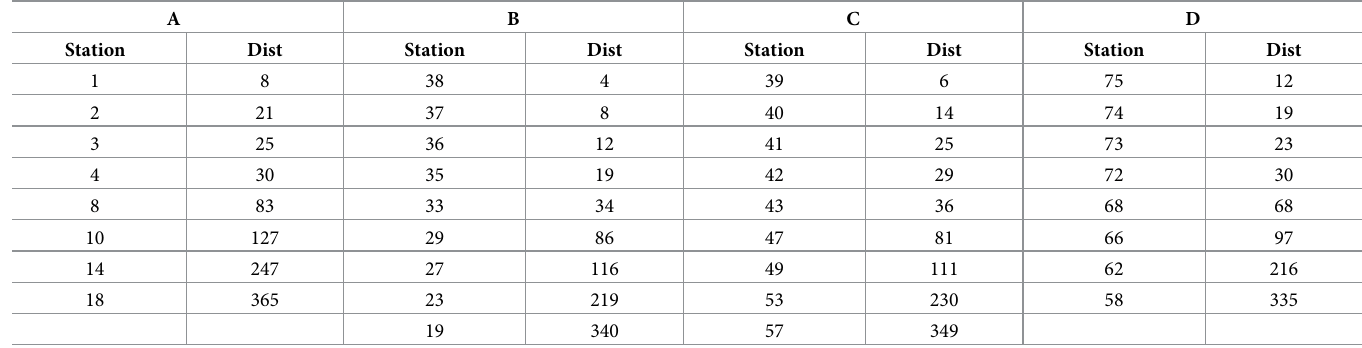
Table 1. Profiling stations by transect A, B, C, and D. Station: Identification number; Dist: Distance from the shoreline to each station (km).